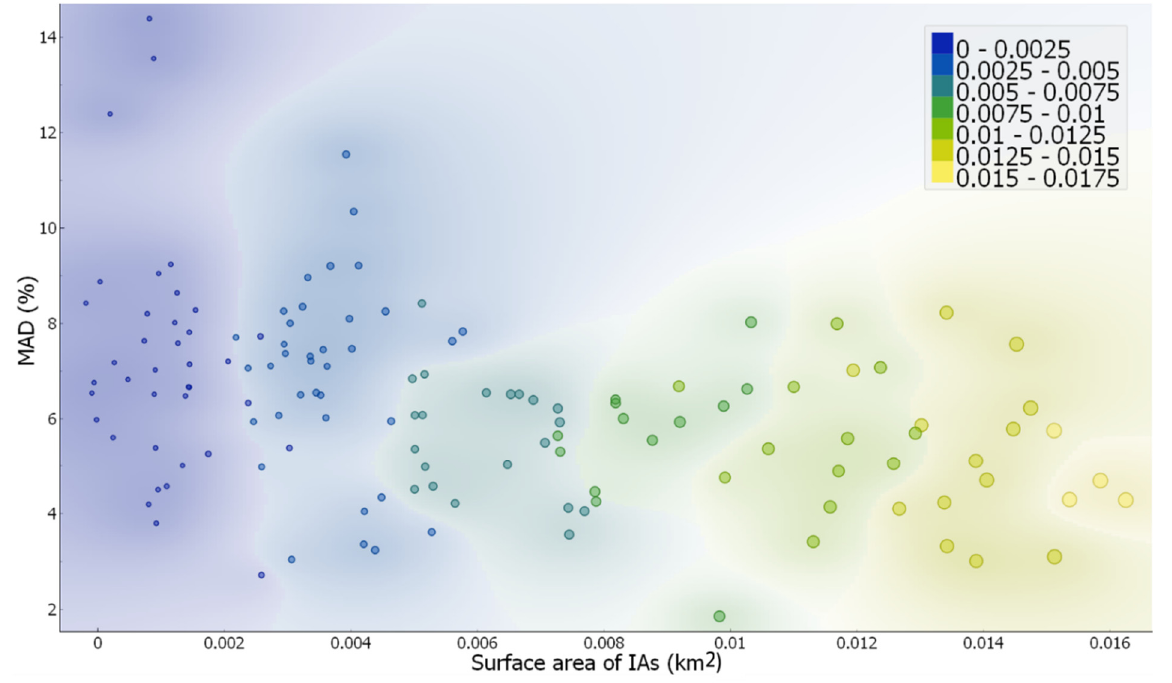
Figure 8. The plot’s y-axis shows the mean area deviation (MAD) values in % for 150 multiple- digitized IAs. The x-axis is the surface area of IAs in km 2 . The color regions inside the plot and the tick mark diameter both depict the size class of IAs, as represented in the label. The darker colours (blue to green) suggest the smaller size of IAs, while the lighter colours (yellow) show large IAs.